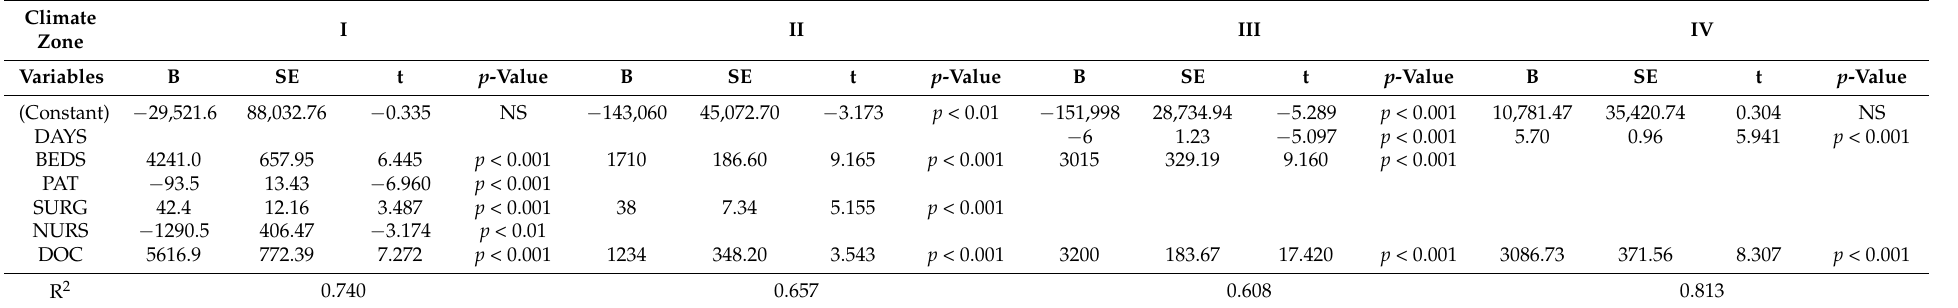
Table 6. Backward stepwise regression analysis with TEC as dependent variable according to the climate zones in